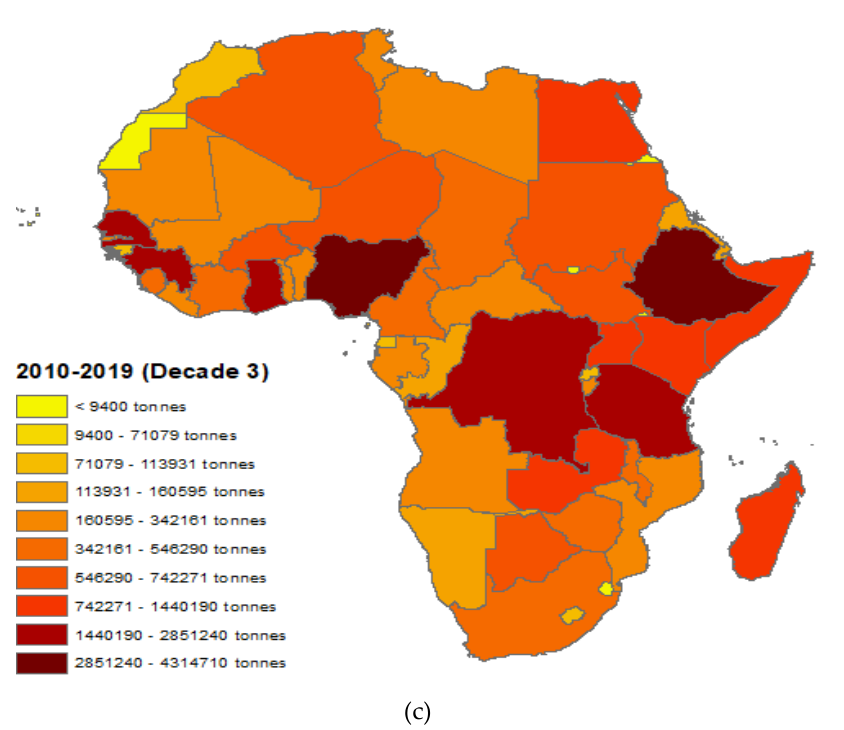
Figure 1. Average Wood Charcoal Production from 1990–2019, ( a ) Decade 1 (1990–1999), ( b ) Decade 2 (2000–2009), and ( c ) Decade 3 (2010–2019). Sources: Authors’ compilation, analysis and mapping from FAOSTAT database.